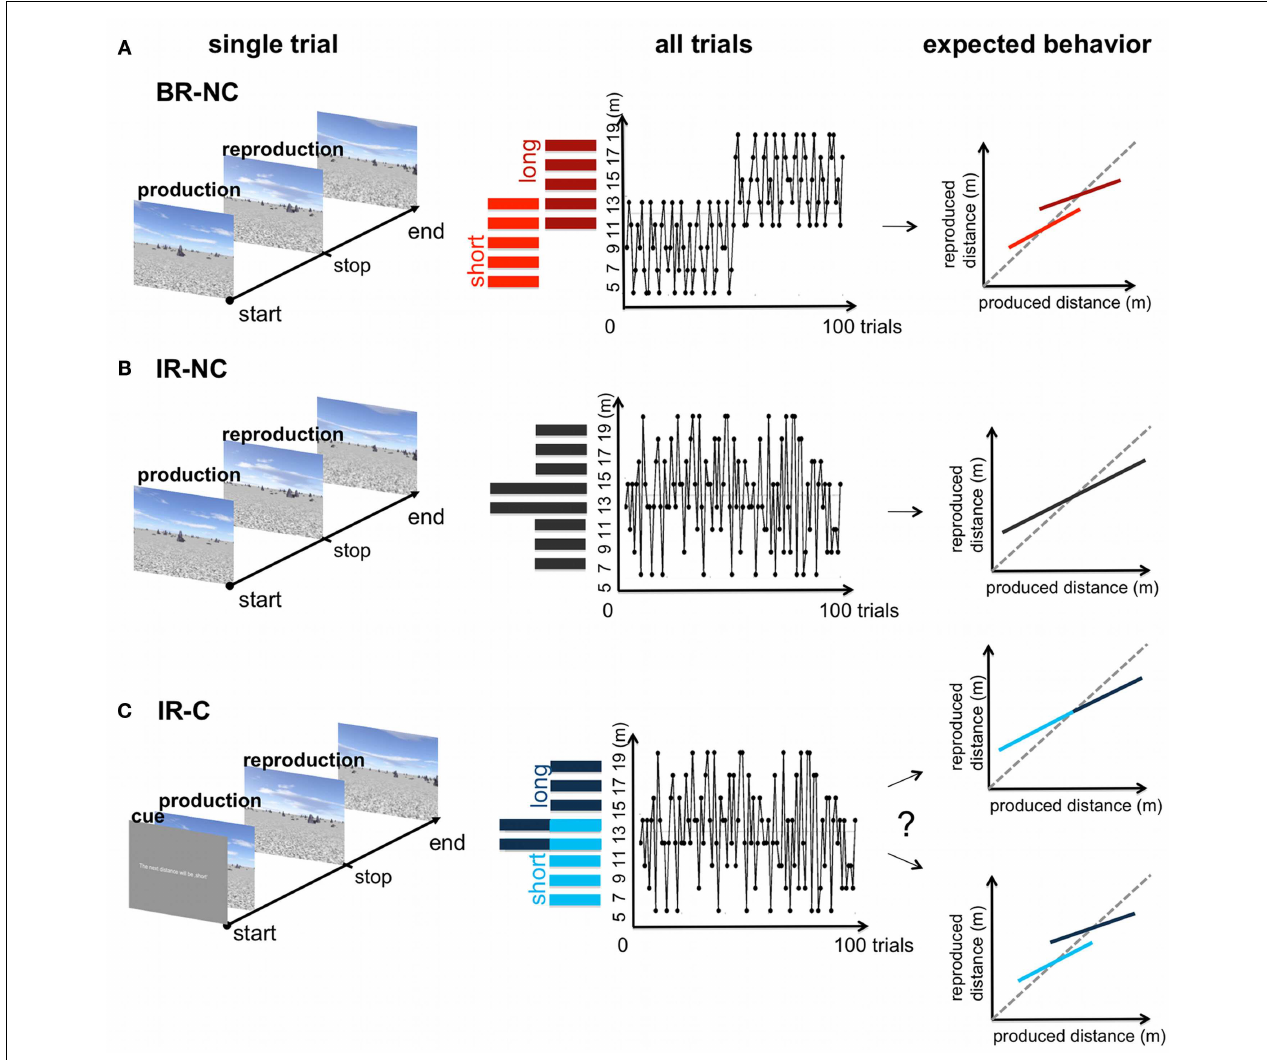
as in (A) where tested in the production-reproduction task, but in a interleaved order resulting in one non-uniform range of randomized sample displacements. (C) IR-C condition: displacements were tested in the exact same order as in (B) , but each trial started with a symbolic cue that indicated either a “short” or “long” displacement. No further information was provided. Depending on the influence of the symbolic cue the resulting behavior could range between the extreme cases mimicked in (A,B)